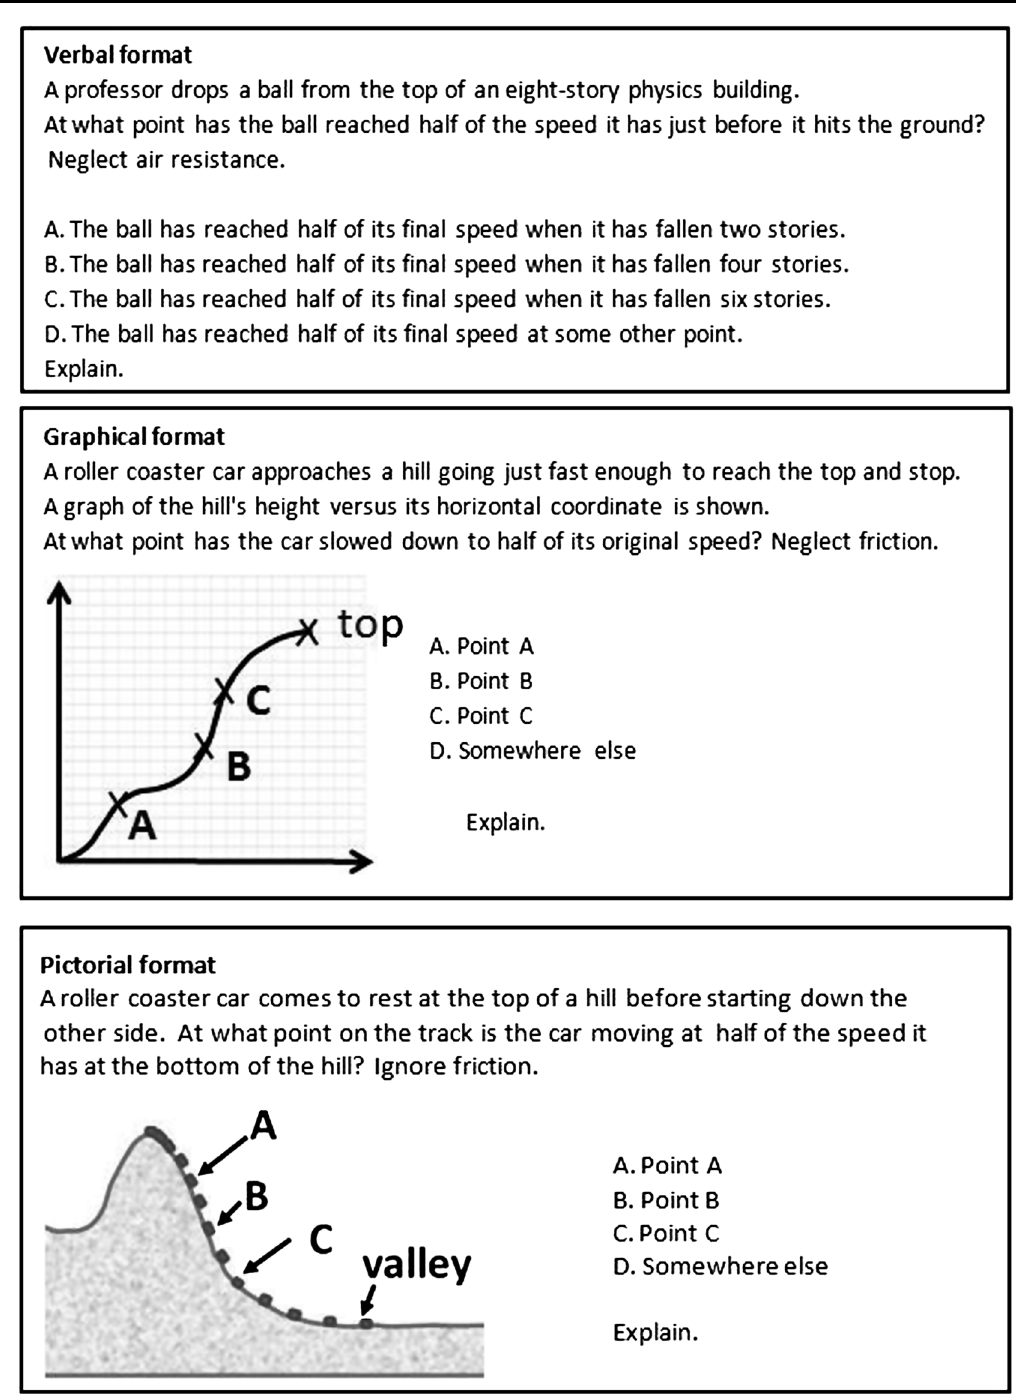
FIG. 1. Verbal, graphical, and pictorial representation of original item